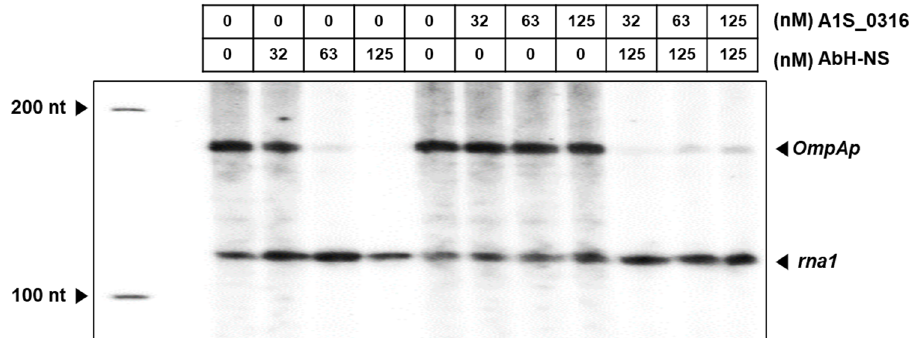
Figure 8. Regulatory effect of A1S_0316 and AbH-NS on AbOmpAp . The role of A1S_0316 and AbH-NS in the regulation of the AbOmpA promoter was examined in the transcription phase in vitro. This assay was validated by the expression of the rna1 RNA, which was the control derived from the plasmid pSA508, carrying AbOmpAp (–231 to +100). The lane on the left corresponds to the 100-nucleotide ladder. The rna1 RNA is 106 nucleotides and AbOmpA is 149 nucleotides. The radioactive AbOmpA transcripts were analyzed on an 8% sequencing gel.